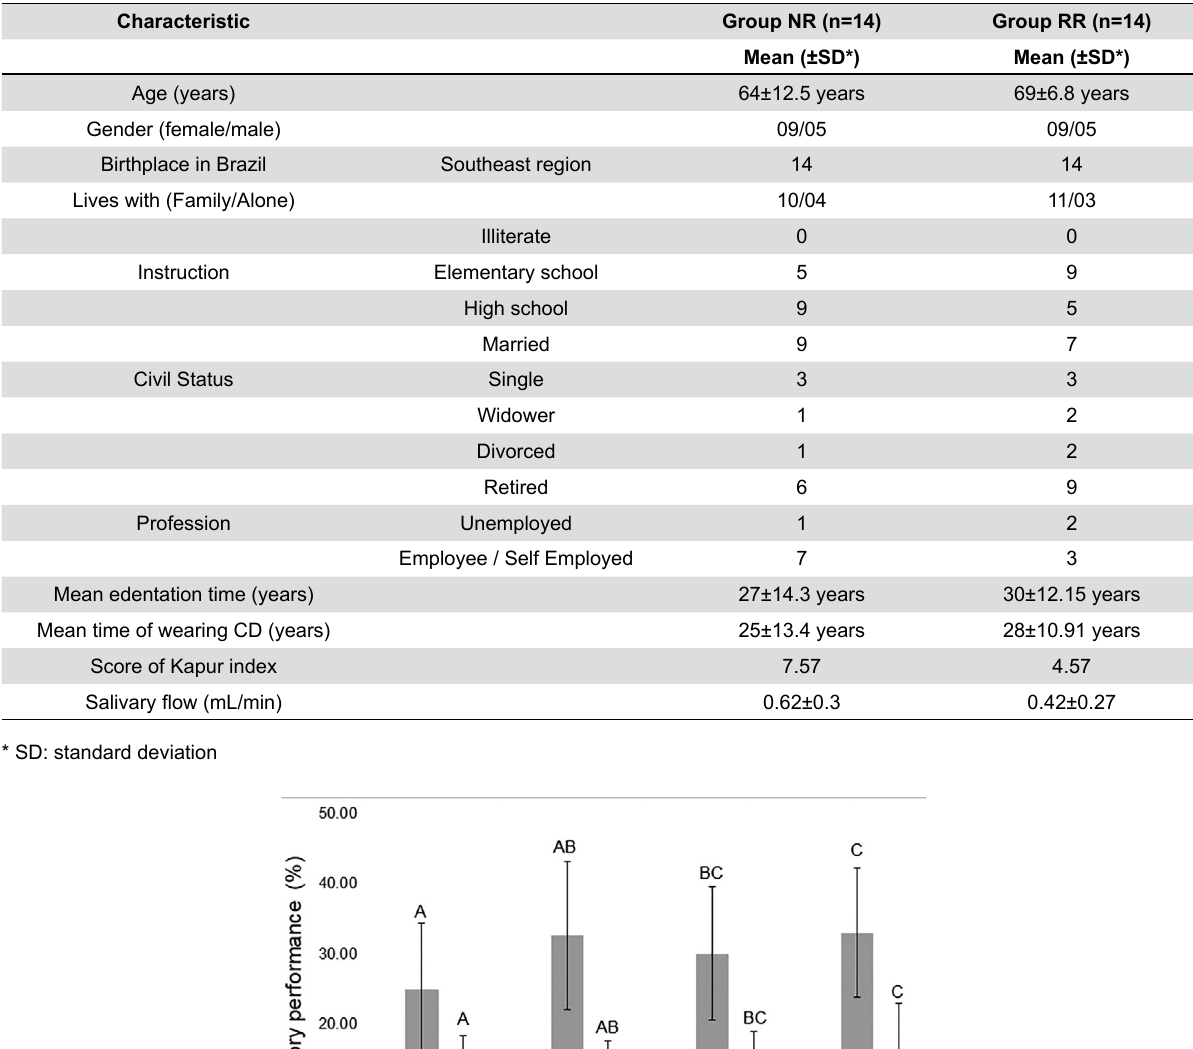
Table1- Clinical characteristics of the participants for each group